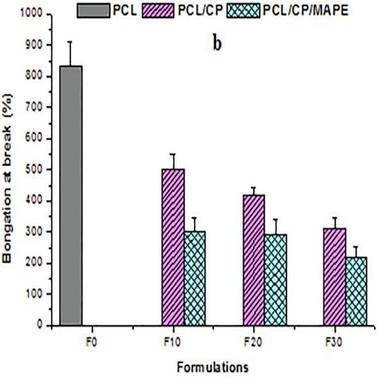
Composites PCL / CP with and without compatibilizer agent. a) Evolution of the tensile strength. b) Evolution of the elongation at break.